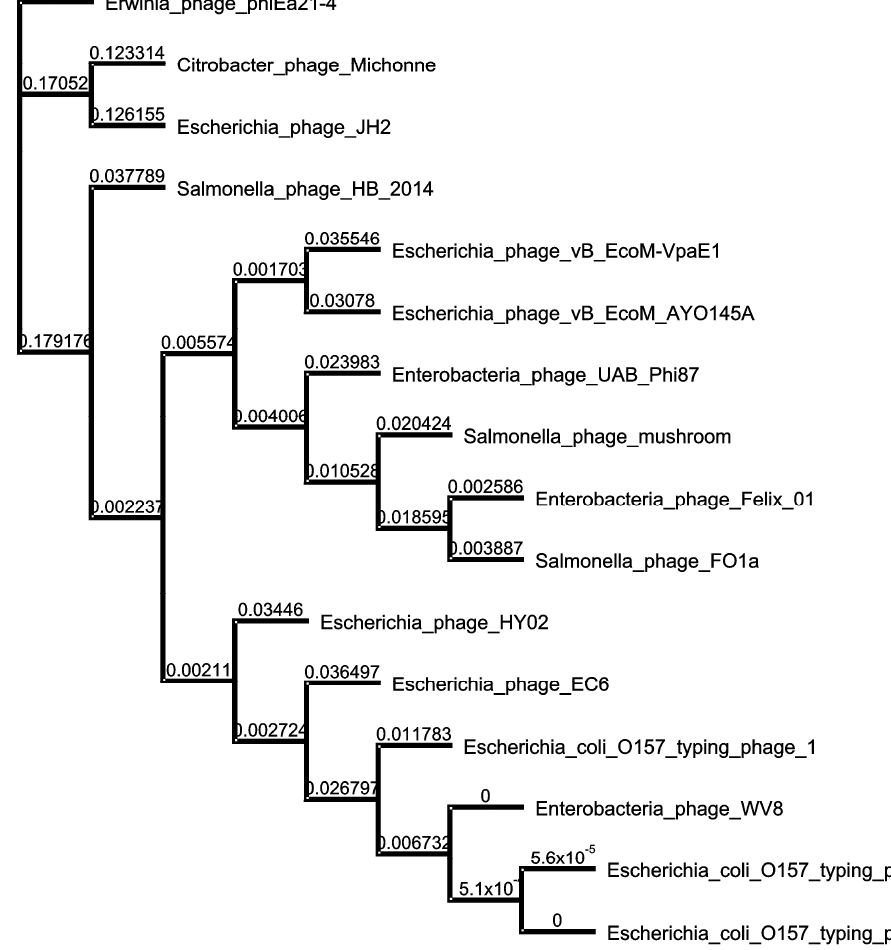
Figure 6. Neighbor-joining tree based on the whole-genome sequence alignment. The numbers at the nodes indicate the bootstrap probabilities.